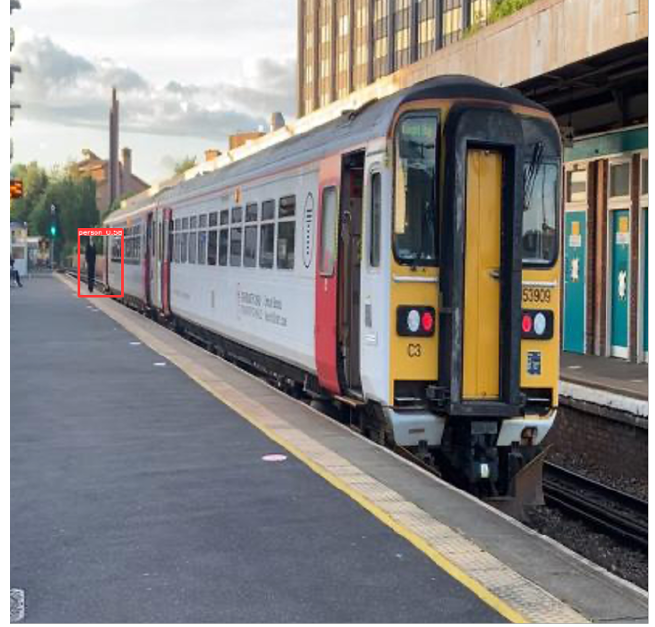
Figure 4. Detection results on YOLOR on custom dataset.